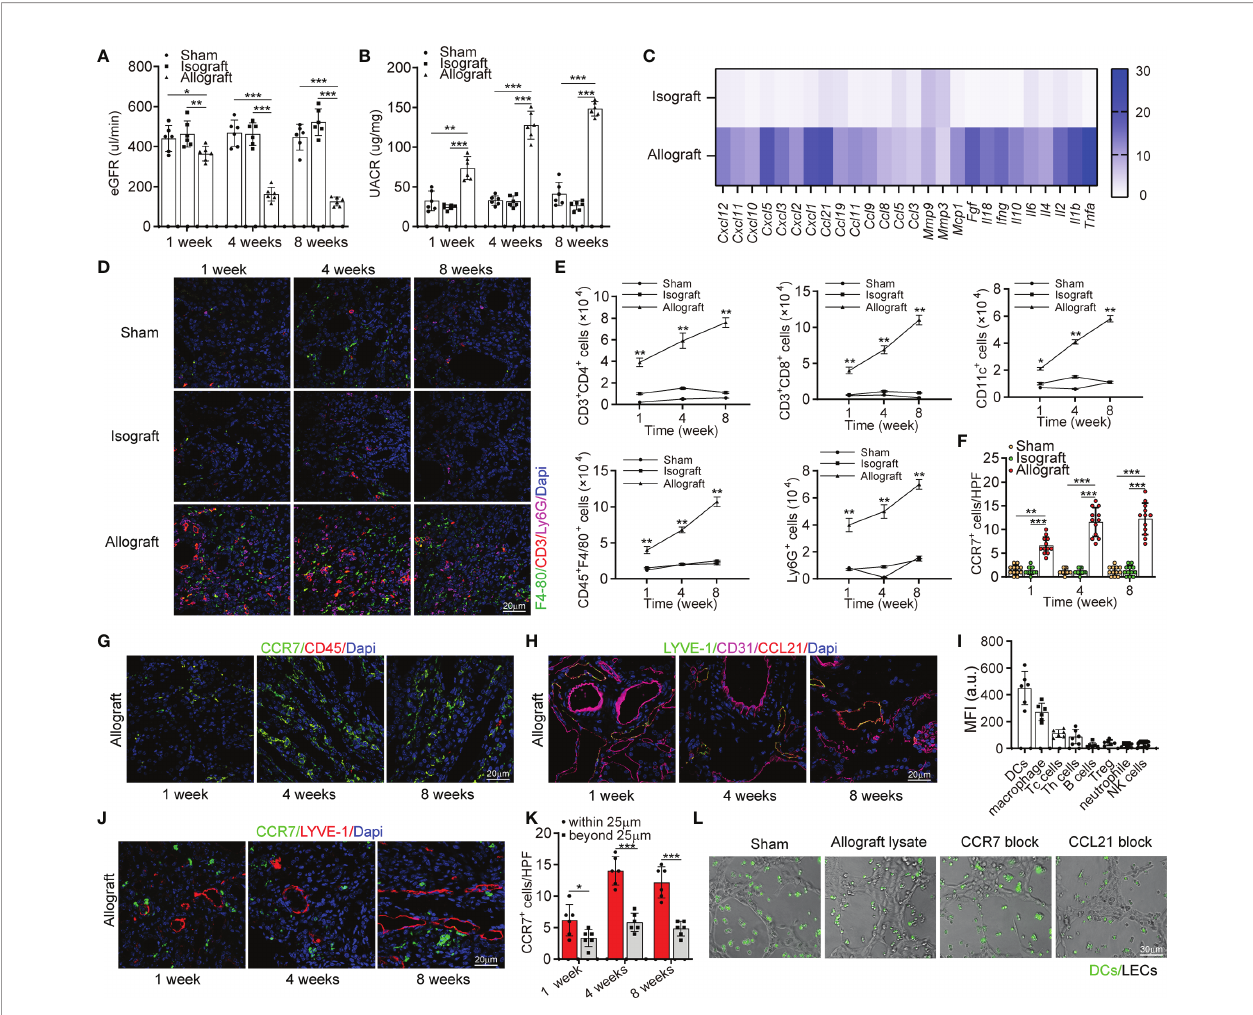
FIGURE 2 | Lymphangiogenesis in renal allograft accompanied with degenerated renal function and in fl ammatory cell in fi ltration mediated by CCL21 expression in lymphatic endothelial cells. (A) eGFR level in sham (n=6 mice), isograft (n=6 mice), and allograft (n=6 mice) groups at 1, 4 and 8 weeks respectively. (B) UACR level in sham, isograft, and allograft groups at 1, 4 and 8 weeks respectively. (C) Messenger RNA expression of pro-in fl ammatory cytokines by multiplex reverse transcription-polymerase chain reaction assay. The heat map displays the relative expression level in isografts and allografts compared to that in the sham control. (D) Representative immuno fl uorescence images showing F4-80 + , CD3 + , Ly6G + cells in sham, isograft, and allograft groups at 1, 4 and 8 weeks respectively. (E) Numbers of Th cells, macrophages, dendritic cells, B cells, and neutrophile granulocytes in sham, isograft, and allograft groups determined by fl ow cytometry at 1, 4 and 8 weeks respectively. (F) CCR7 + cell counting in sham, isograft, and allograft groups at 1, 4 and 8 weeks respectively. (G) Immuno fl uorescence of CCR7 + , and CD45 + cells in allografts at 1, 4 and 8 weeks respectively. (H) Representative immuno fl uorescence images showing LYVE-1 + , CD31 + and CCL21 + cells in allografts at 1, 4 and 8 weeks respectively. (I) FACS analysis of the different CCR7 + cell types in kidney allograft in fi ltrated CD45 + immune cells: DCs (CD45 + and CD11c + ), macrophage (CD11b + and F4/80 + ), cytotoxic T cells (CD8 + ), T helper cells (CD4 + ), B cells (CD19 + ), Treg cells (CD4 + , CD25 + and FOXP3 + ), neutrophils (CD11b + and Ly6G + ) and NK cells (NK1.1 + ). (J) Representative immuno fl uorescence images showing the distribution of CCR7 + cells and LYVE-1 + cells in allografts to con fi rm the chemotaxis at 1, 4 and 8 weeks respectively. (K) Cell counting of CCR7 + cells that have different distances (within or beyond 25 m m) from lymphatic endothelial cells. (L) Representative images of dendritic cells migrating to lymphatic capillary-like structures. All scale bars represent 20 m m. *P < 0.05, **P < 0.01, ***P < 0.001. Values are mean ±